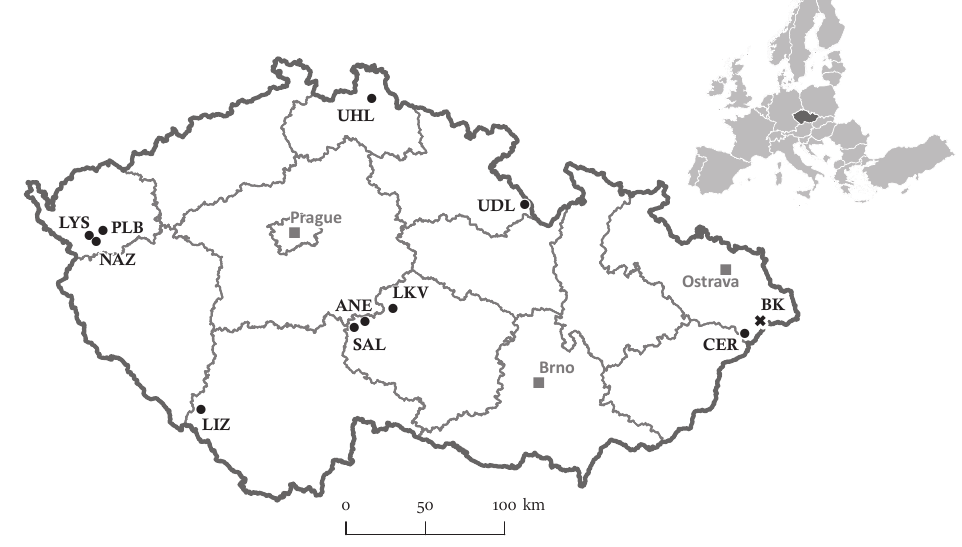
Figure 2. Location of small forested stream catchments within the GEOMON long-term monitoring network (circles with labels) and the Bílý Kˇríž site (cross with BK label) in the Czech Republic. The sites are characterized (and abbreviations explained) in Table